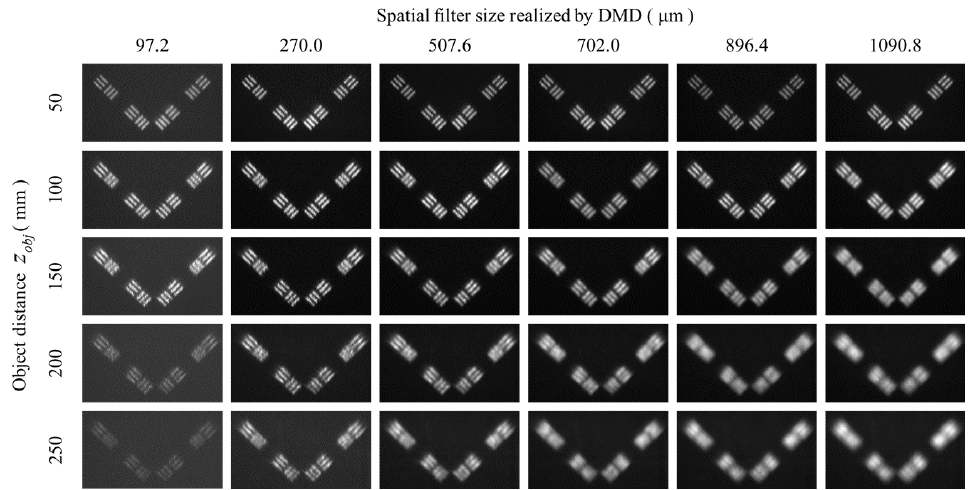
Figure 9. Reconstructed images depending on the spatial filter size of 97.2, 270.0, 507.6, 702, 896.4, and 1090.8 µ m.